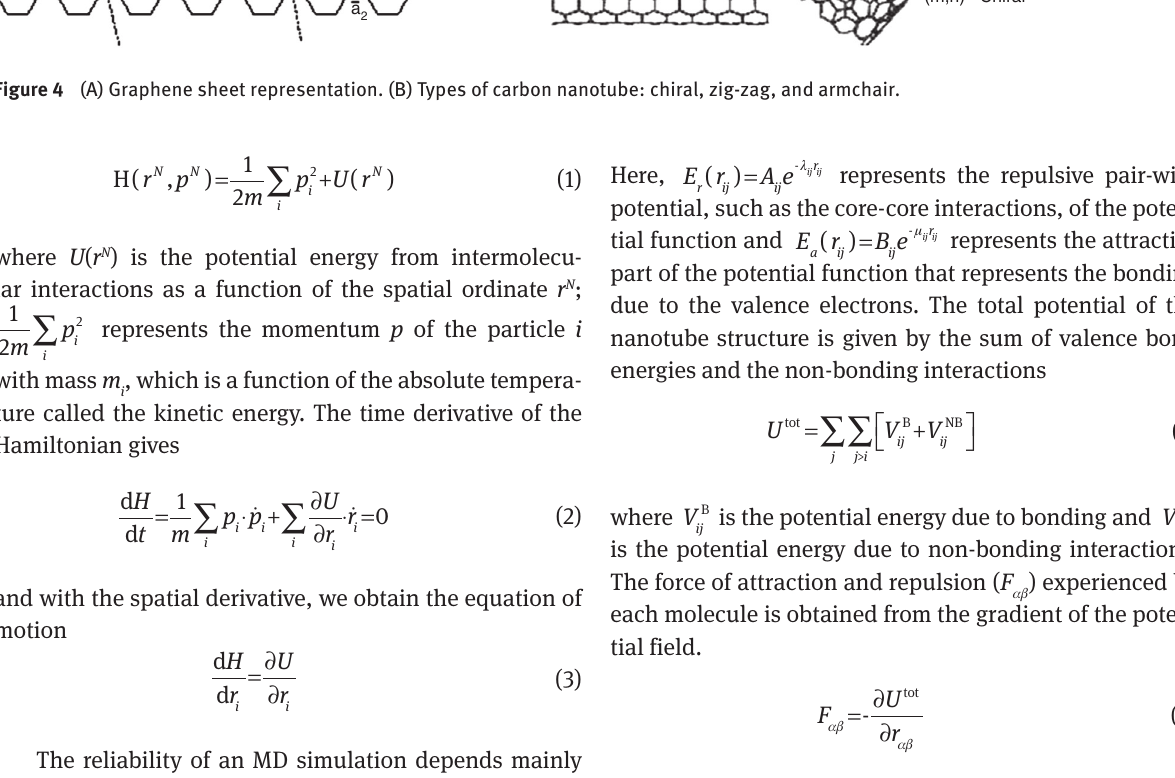
Figure 4 (A) Graphene sheet representation. (B) Types of carbon nanotube: chiral, zig-zag, and armchair.